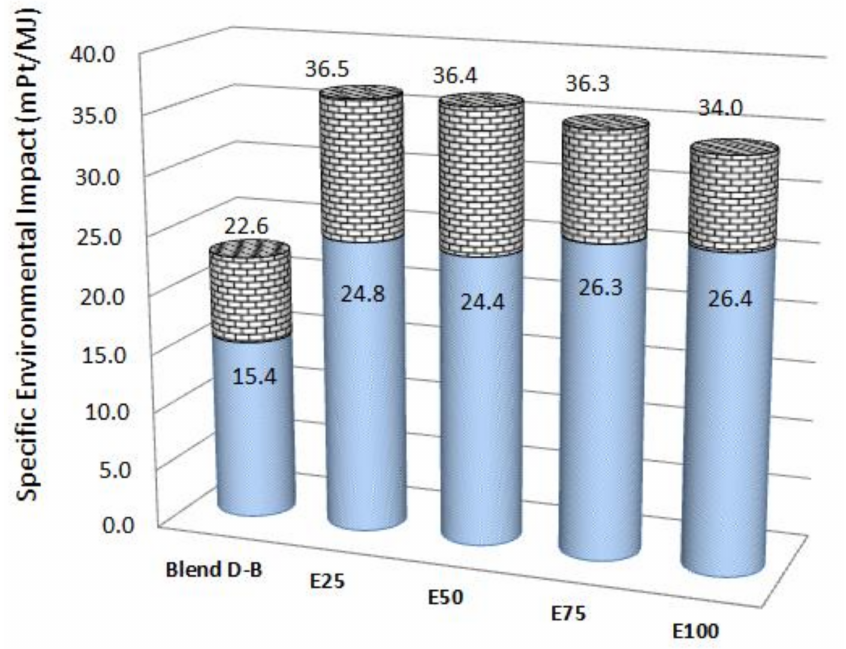
Figure 7. Range of environmental impacts per exergy unit for different fuels and